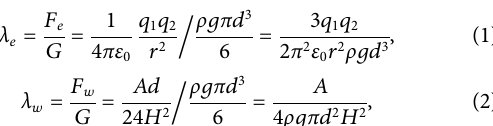
FIGURE 5 Relationship of CRFW with particle